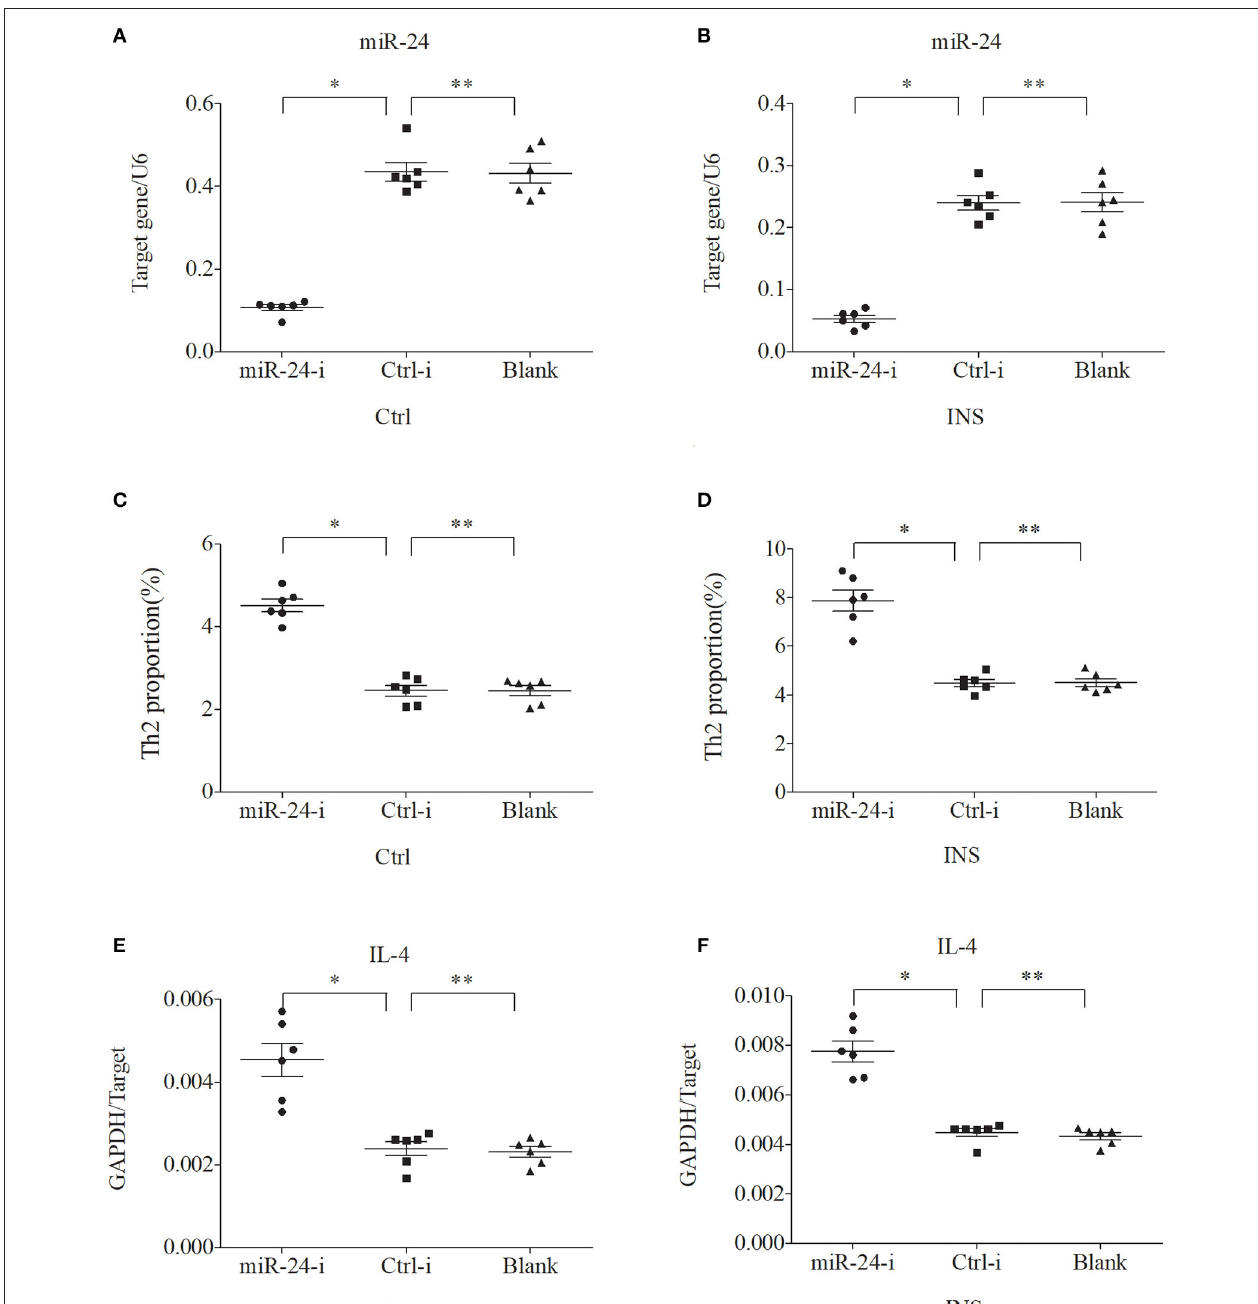
FIGURE 6 | Down regulation of miR-24 in PBMCs from controls and INS patients (A,B) increases the percentage of Th2 cells (C,D) and the expression of IL-4 mRNA (E,F) . * P < 0.05 and ** P > 0.05.